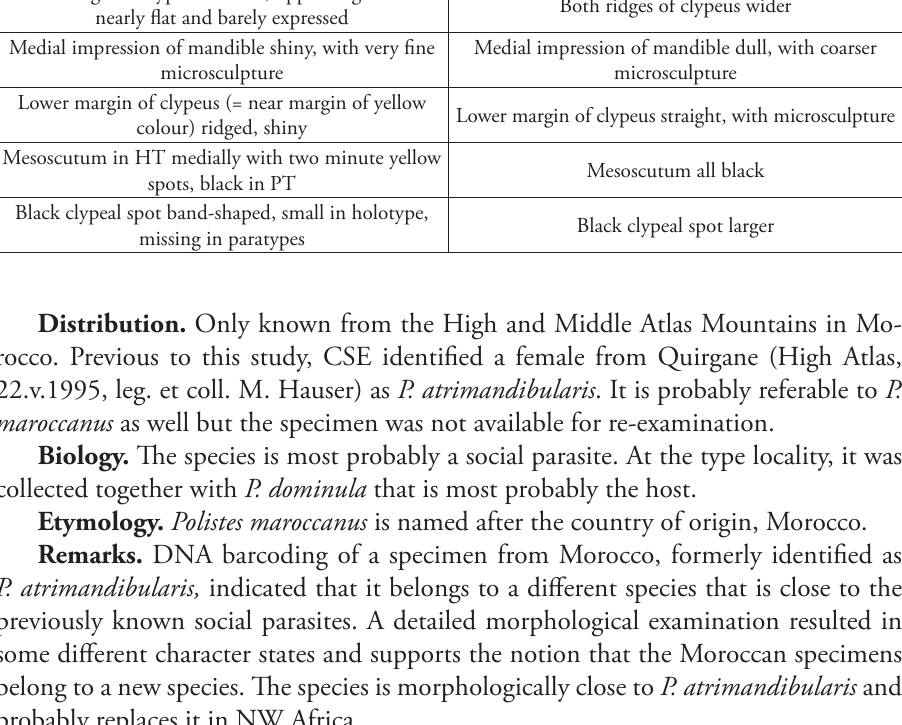
Table 2. Characters for separating P. maroccanus from P. atrimandibularis (females only, HT = Holotype, PT = Paratype). Lower ridge of mandible narrow, in HT= 0.22× (in Lower ridge of mandible wider, 0.37× as wide as PT= 0.24×) as large as mandible (measured medially) mandible Both ridges of clypeus smaller, upper ridge in PT Both ridges of clypeus wider nearly flat and barely expressed Medial impression of mandible shiny, with very fine Medial impression of mandible dull, with coarser microsculpture microsculpture Lower margin of clypeus (= near margin of yellow Lower margin of clypeus straight, with microsculpture colour) ridged, shiny Mesoscutum in HT medially with two minute yellow Mesoscutum all black spots, black in PT Black clypeal spot band-shaped, small in holotype, Black clypeal spot missing in paratypes